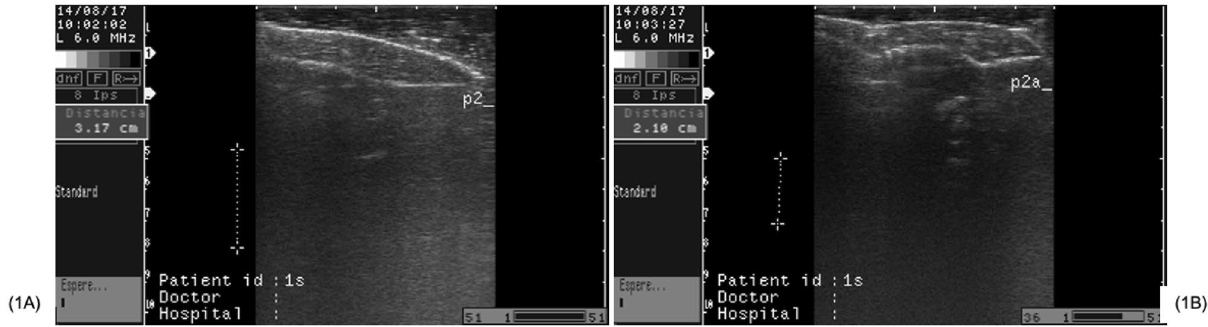
Figure 1. The ultrasound images of M. pectoralis major , in domestic quail ( Coturnix japonica ). ( A ) Longitudinal positions; ( B ) Transverse